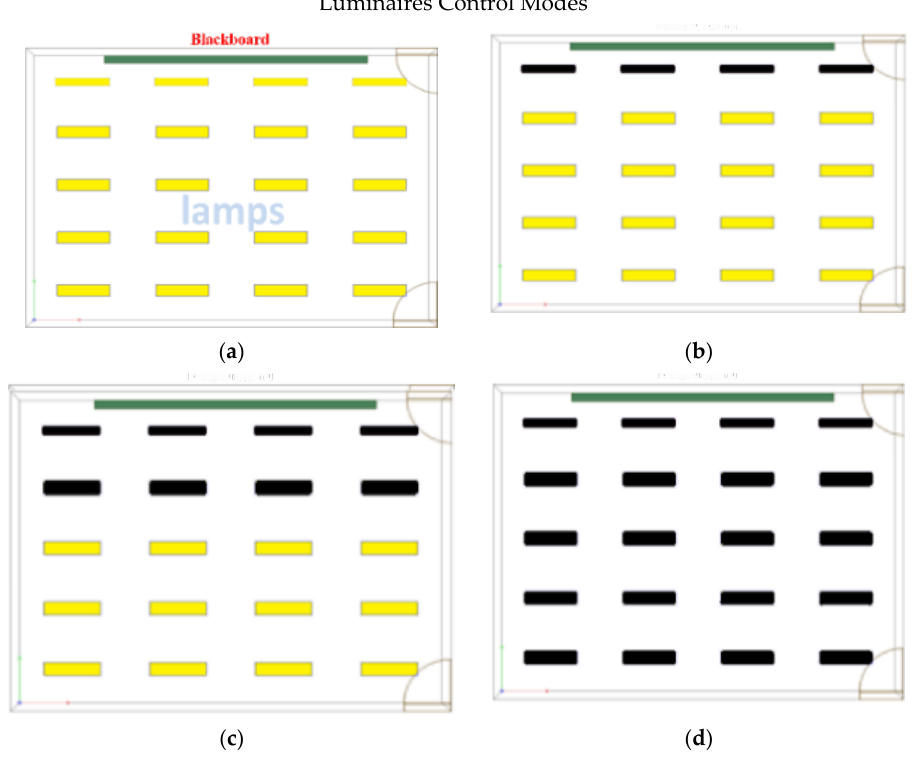
Figure 6. Schematic diagram for different luminaires control modes. Yellow means the light turns on, black means it turns off. ( a ) Level 1, ( b ) Level 2, ( c ) Level 3, ( d ) Level